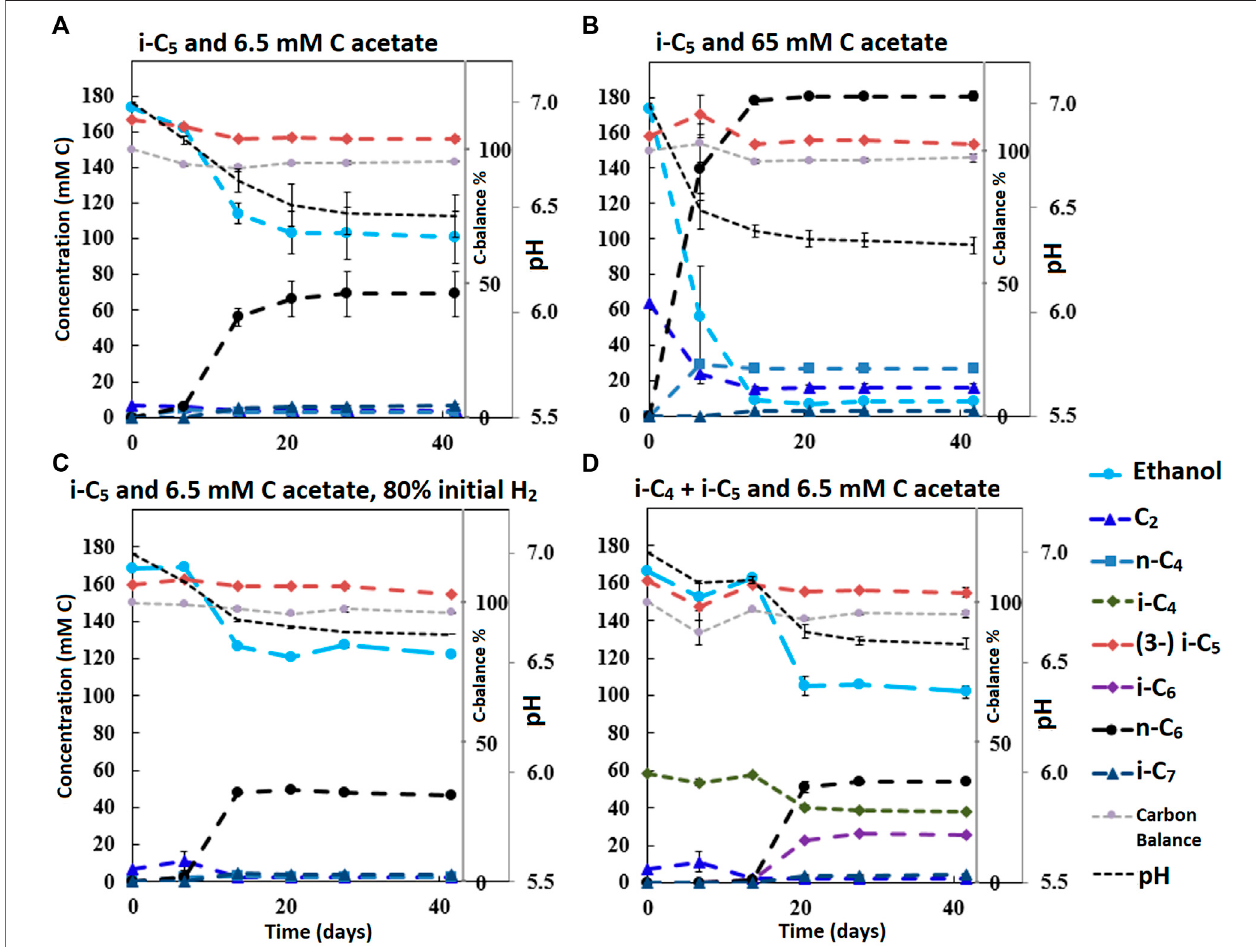
FIGURE2 | Concentration pro fi les ofbatchesperformed with i-C 5 asadditional electron donor and varyinglevels ofstarting acetateamounts and hydrogen partial pressures (A – C) .Batch (D) showsthepreferencefori-C 4 overi-C 5 asalternativeelectronacceptorleadingtobranchedMCFAformationconcomitantwithstraightchain elongation. The i-C 5 addition results only in marginal i-C 7 formation. Concentration pro fi les ofcomponents thatwerepresent in lower concentration ranges are shown in Supplementary Figure S7 .